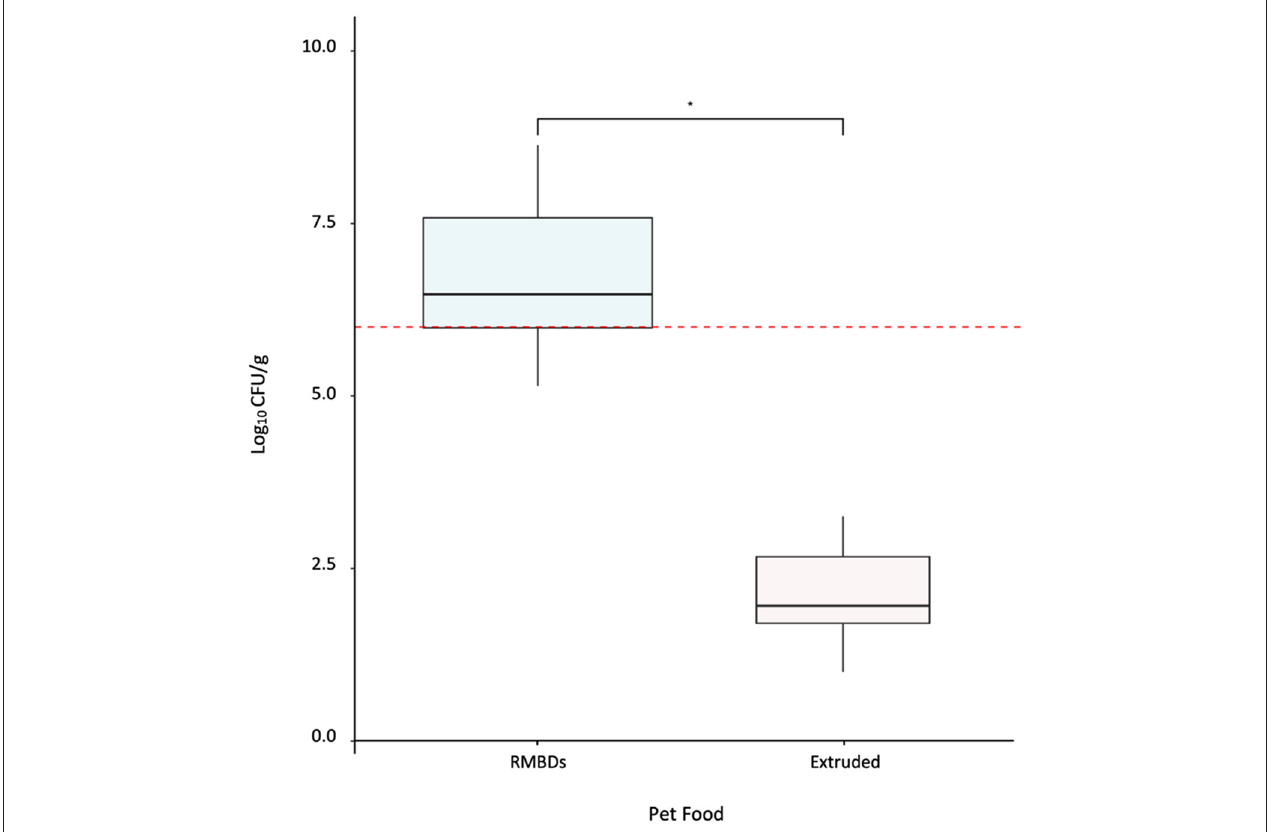
FIGURE 1 | Aerobic bacterial counts (APC) for RMBDs ( n = 42) and extruded ( n = 24). The Fligner-Killeen test was used to determine the homogeneity of variances (homoscedasticity) and Shapiro-Wilk test for normality. The level of APC between both diets was compared using Welch’s Two-Sample T-test * p -value < 2.20 × 10 − 16 . The red line shows the suggested APC upper limit for animal compound feed according to Kukier et al. ( 19). RMBD’s APC > 1 × 10 6 CFU/g =